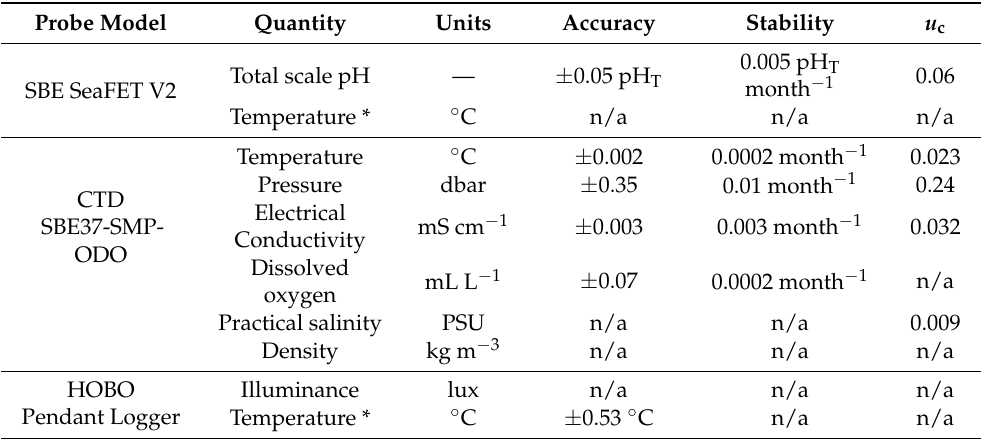
Table 1. Main metrological features of employed probes as reported by datasheets. Temperatures (*) were acquired but are not presented in this paper. CTD temperature values are the most reliable, thus indicated in the table and used in the paper. The symbol u c indicates the available (or calculated) combined standard uncertainty. N.a.: not